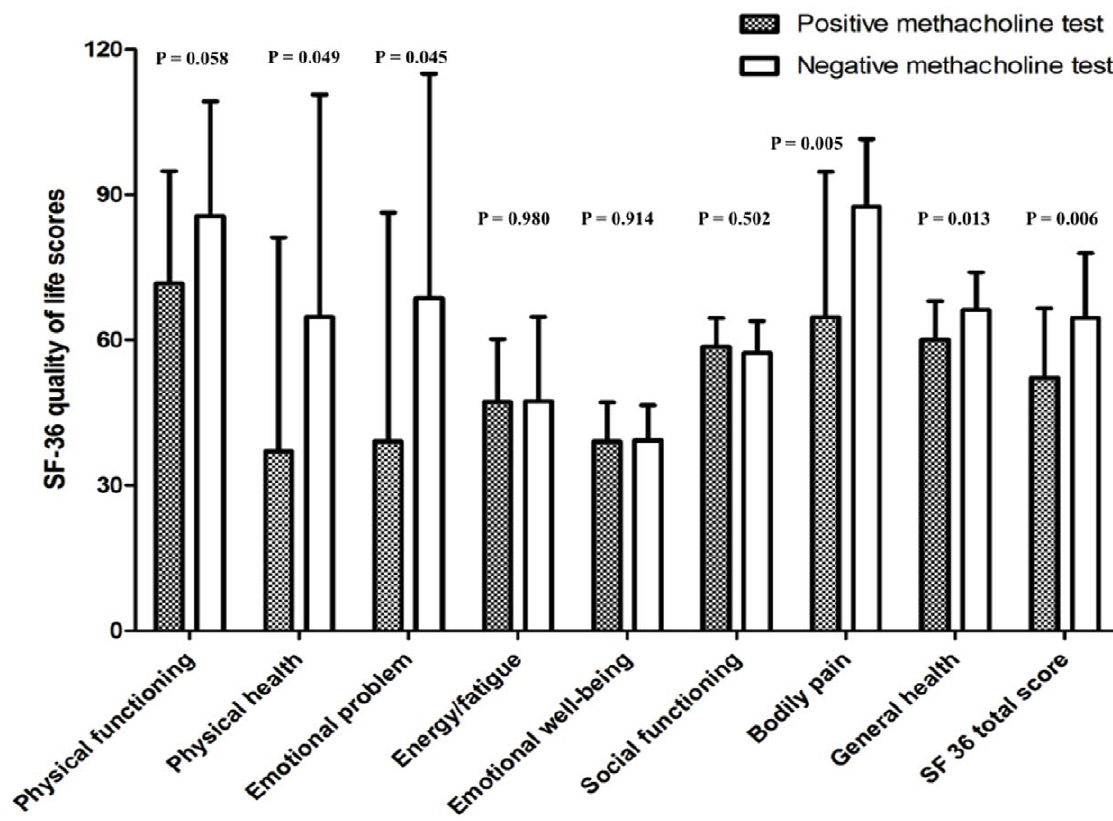
Figure 1. Comparison of SF-36 health-related quality of life scores according to the response to methacholine challenge test.